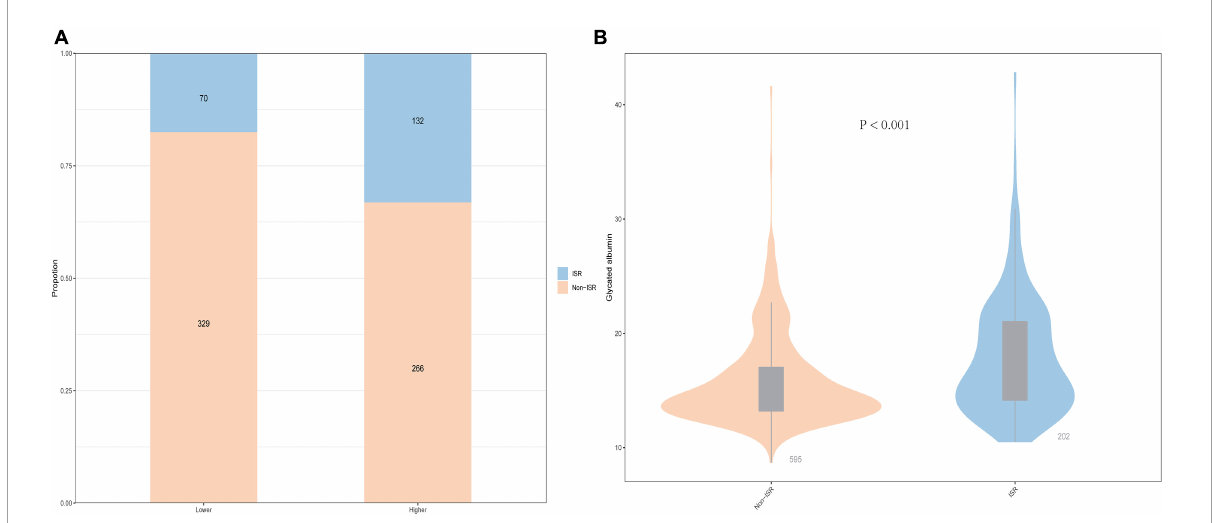
FIGURE1 The impacts of the GA levels on the prevalence of DES-ISR (A) and comparison of the GA levels between the non-ISR and ISR groups (B) in patients with ACS. ACS, acute coronary syndrome; GA, glycated albumin; DES, drug-eluting stent; ISR, in-stent restenosis.